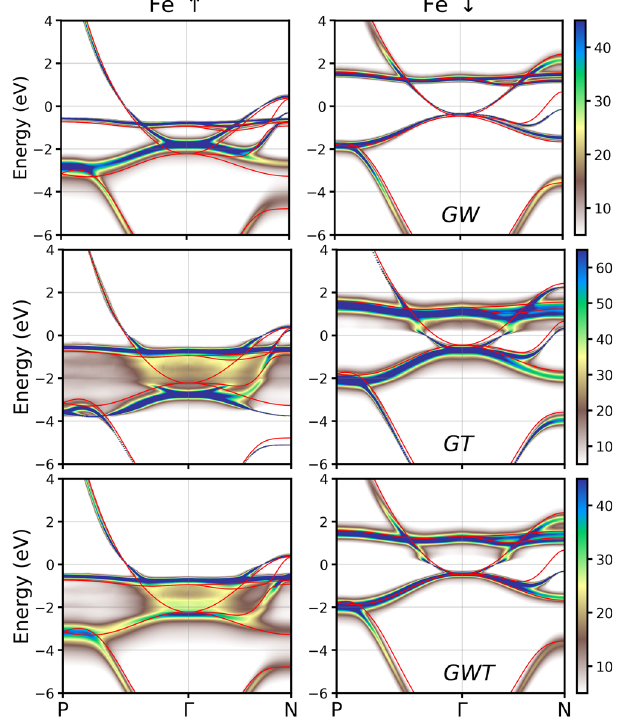
Fig. 1 Renormalized band structures of bcc Fe. Spin majority and minority band structures of bcc Fe renormalized with GW , GT , and GWT self-energies along P – Γ – N. The spectral functions [Eq. (8)] are represented as color-coded 2D plots. The LSDA band structure is shown as red